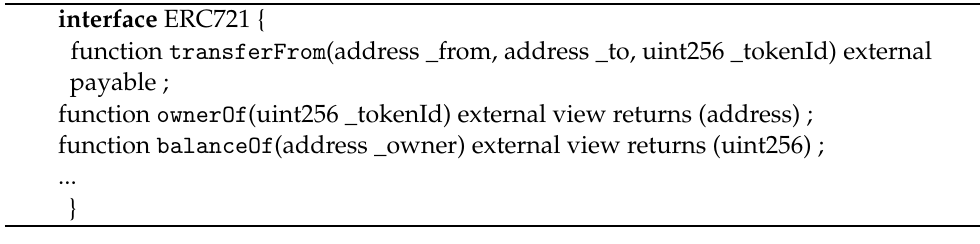
Algorithm 2: ERC-1155 Standard Interface interface ERC1155